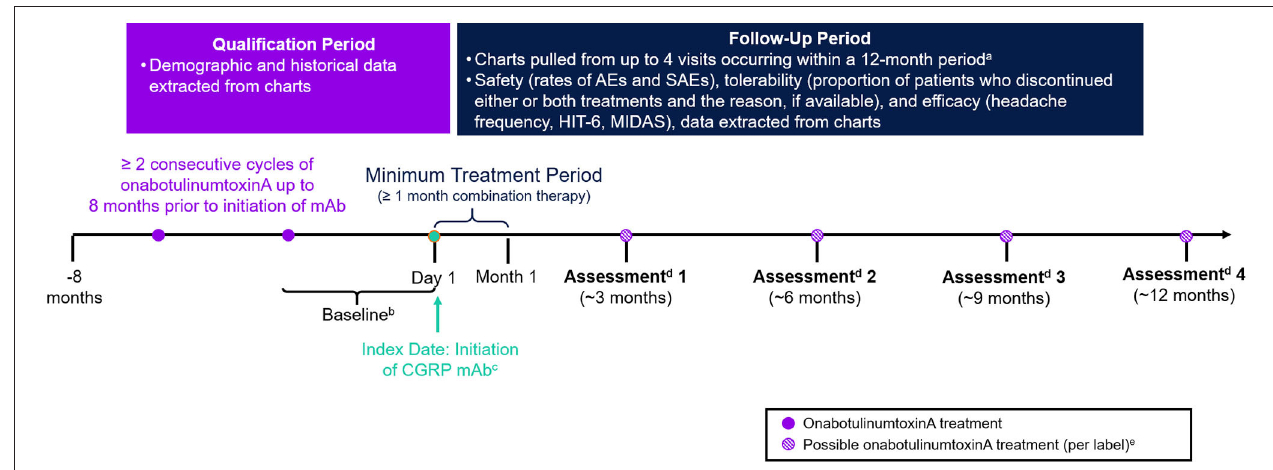
FIGURE 1 | Study design. CGRP, calcitonin gene–related peptide; HIT-6, Headache Impact Test; mAb, monoclonal antibody; MIDAS, Migraine Disability Assessment. a Not all patients had 4 visits or 12 months of data. b Baseline assessments for outcome measures (e.g., headache day frequency, headache intensity, and disability) were collected from the visit at which the CGRP mAb was prescribed and reflect patient assessments during ∼ 1–3 months prior to initiation of the CGRP mAb. c CGRP mAbs were self-administered by subcutaneous injection. Per label, erenumab, fremanezumab, and galcanezumab are administered once monthly. d Each assessment was based on data from chart extraction. e OnabotulinumtoxinA treatment is not always administered per